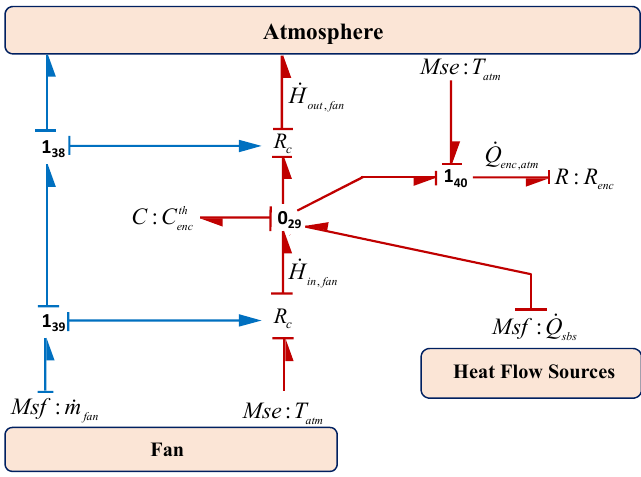
Figure 18. BG sub-model of system enclosure in capsule